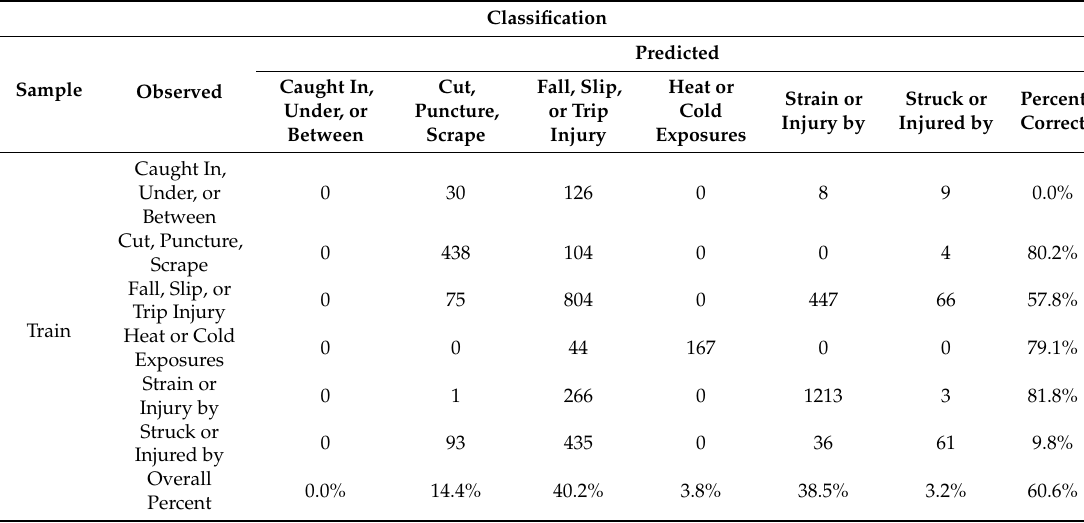
Table 5. Performance of RB NN Model for Train and Test Data